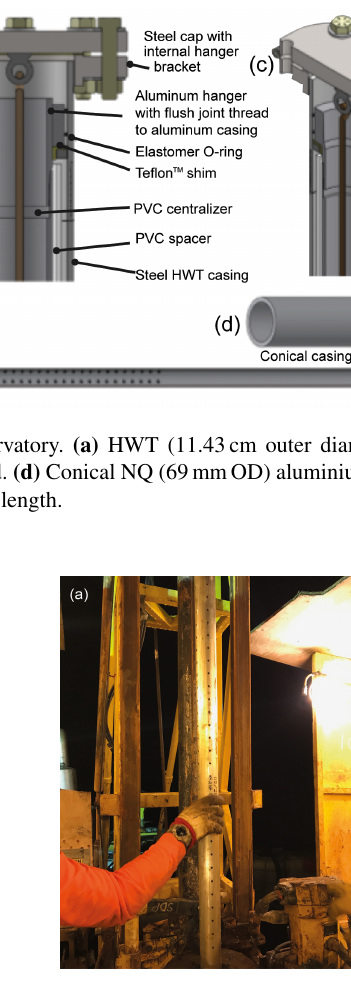
Figure 4. Photographs of drilling operations illustrating compo- nents of the borehole observatory. (a) Perforated casing interval as it is lowered into the borehole; (b) the open wellhead of the observa- tory. (c) Drill site and operations on Surtsey volcano. Photo credits: (a) Andreas Türke, (b) Stephen Cole and (c) Beau